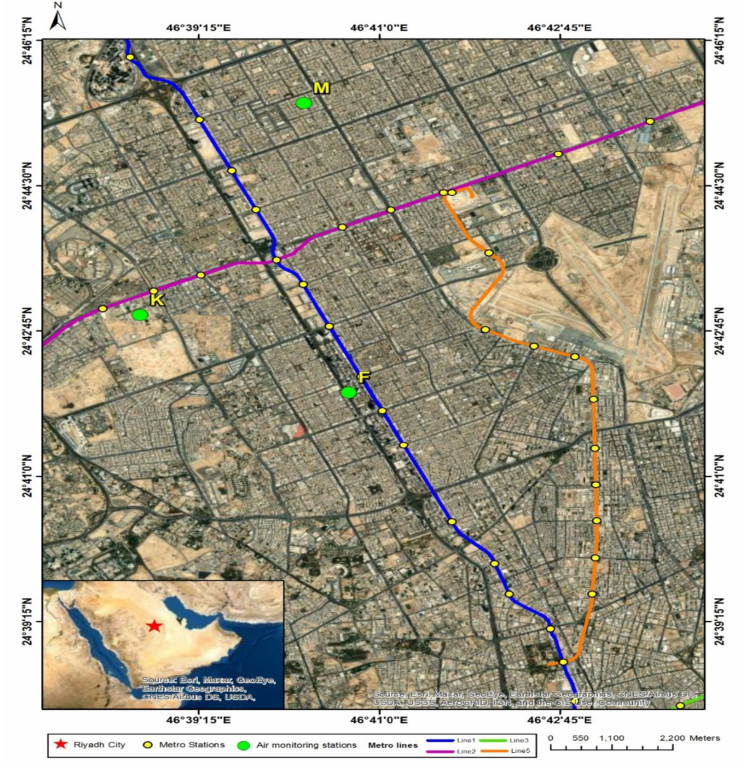
Figure 1. Locations of air-quality-monitoring stations used in this study and metro stations in Riyadh